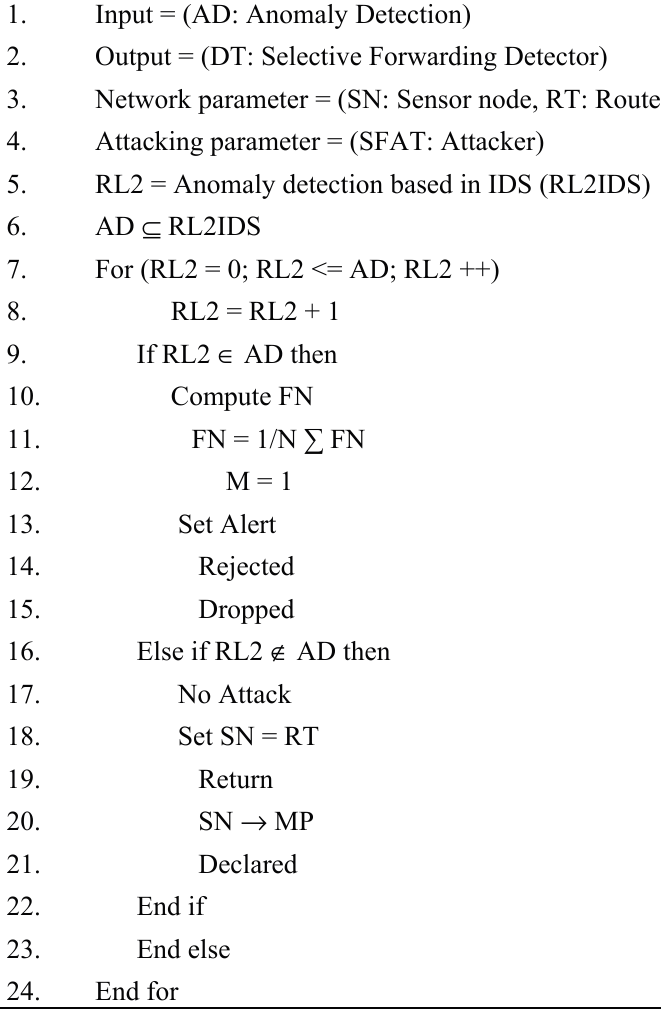
Algorithm 3. Anomaly Detection Layer Based on